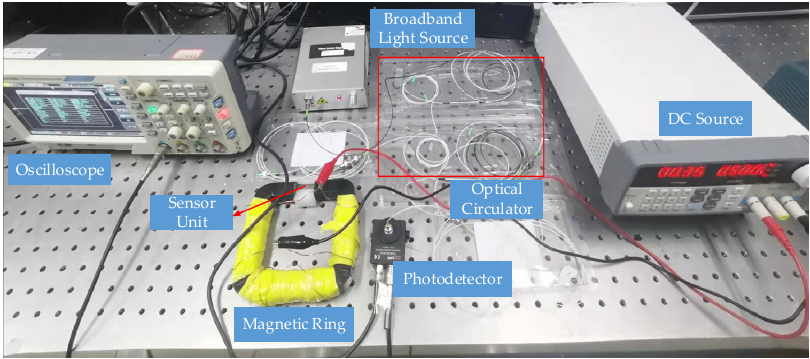
Figure 10. Test platform for DC response characteristics of sensor .